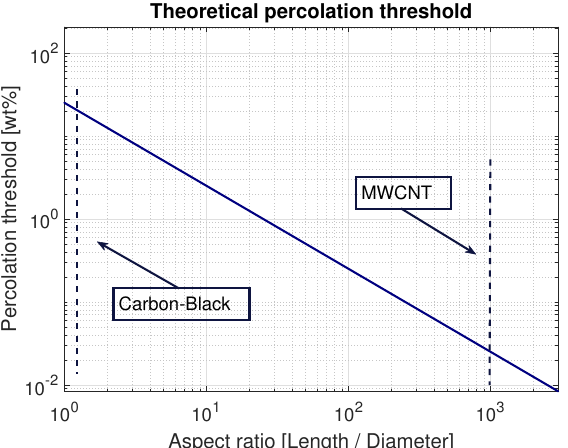
Figure 1. Theoretical percolation threshold according to the equation from Chen et al. [17]. Carbon- Black particles have an aspect ratio of 1, and carbon nanotubes are several orders